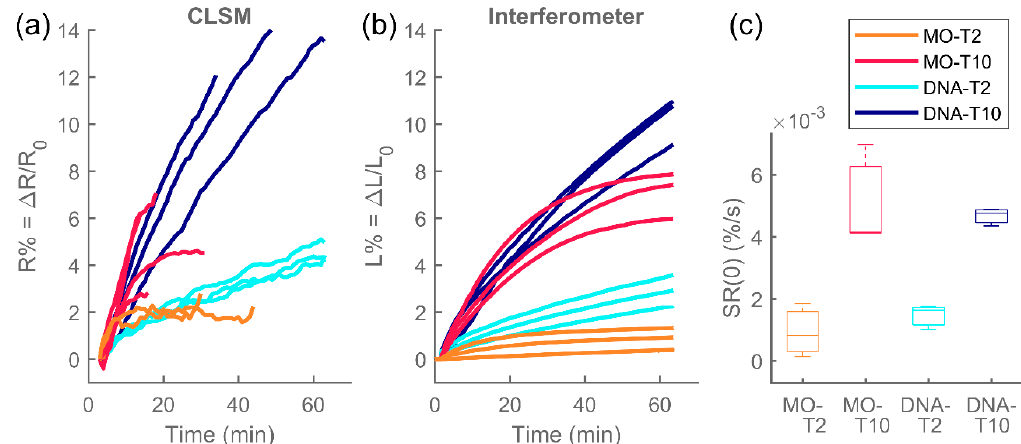
Figure 5. Relative swelling kinetics of Morpholino and DNA hydrogels after exposure to Morpholino and DNA (respectively) targets T2 or T10 at t = 0. In ( a ), relative swelling as calculated from CLSM micrographs, reflecting changes in the hydrogel’s physical length. In ( b ), relative swelling obtained by interferometry, reflecting the optical length changes. In ( c ), box plots of initial swelling calculated from the interferometer curves. The interferometric and CLSM measurements were conducted on separate hydrogel preparations.